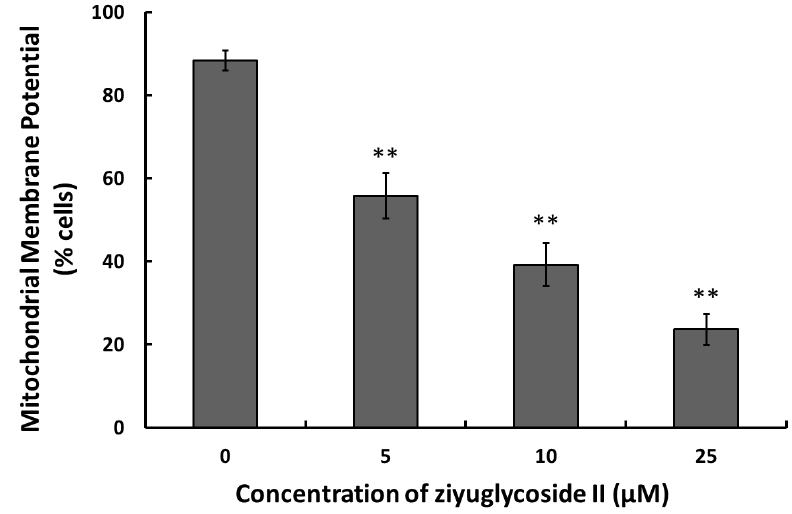
Figure 5. The effect of ziyuglycoside II on the mitochondria membrane potential (MMP) in MDA-MB-435 cells. Cells were incubated with various concentrations of ziyuglycoside II for 24 h and then harvested for MMP determination as described in Materials and Methods. All data were expressed as mean ± SD of three experiments and each experiment included triplicate repeats. * p < 0.05, ** p < 0.01 vs.